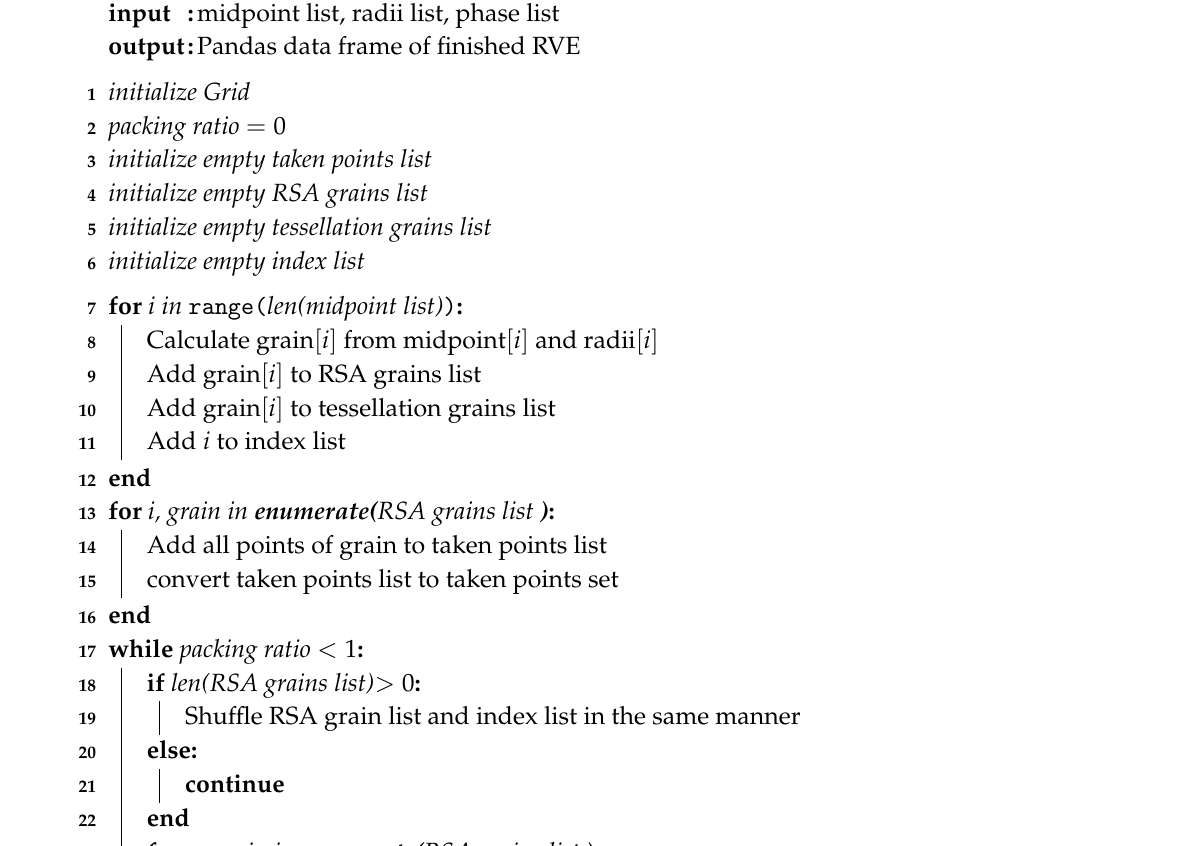
Algorithm 2: Discrete Random Sequential Addition